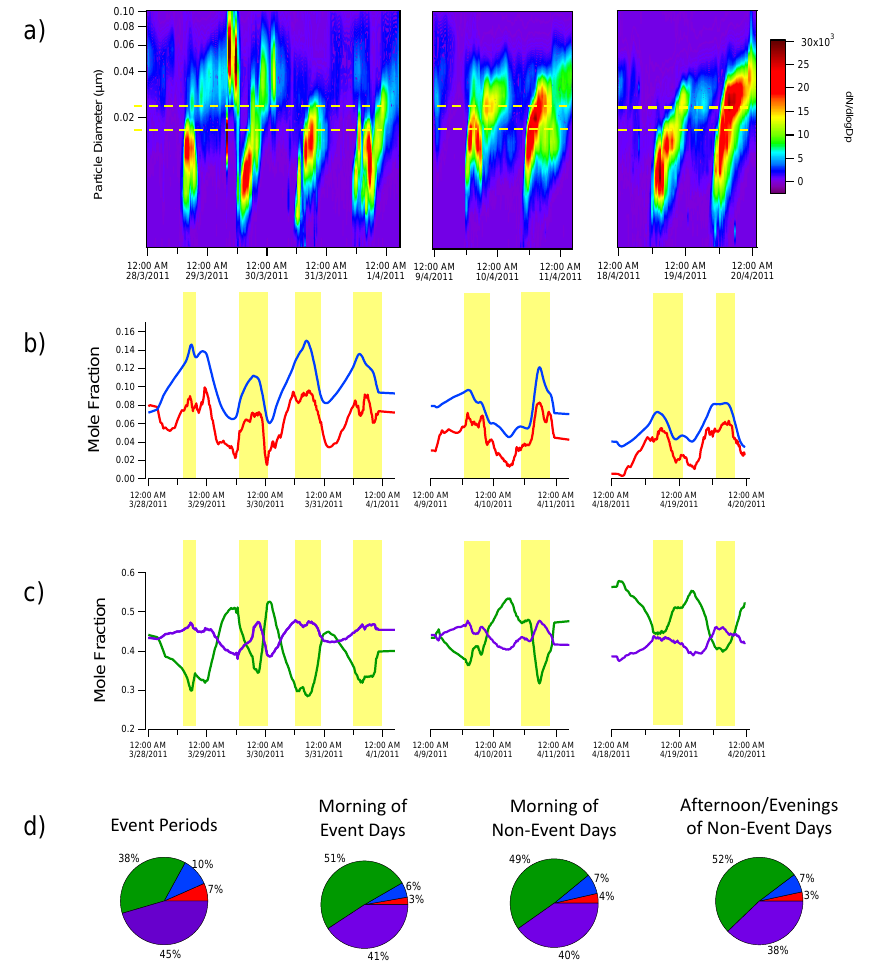
Fig. 2. (a) Particle size distributions for eight days when NPF occurred. (b) Elemental mole fractions of nitrogen (blue) and sulfur (red). (c) Elemental mole fractions of carbon (green) and oxygen (violet). Elemental mole fractions were subjected to 10-point boxcar smoothing; shaded regions show approximate time periods when the particle mode diameter was within the NAMS size range. (d) Average elemental compositions of particles sampled during NPF events, in the mornings of event days (02:00–09:00LT), in the mornings of non-event days (02:00–09:00) and in the afternoons/evenings of non-event days